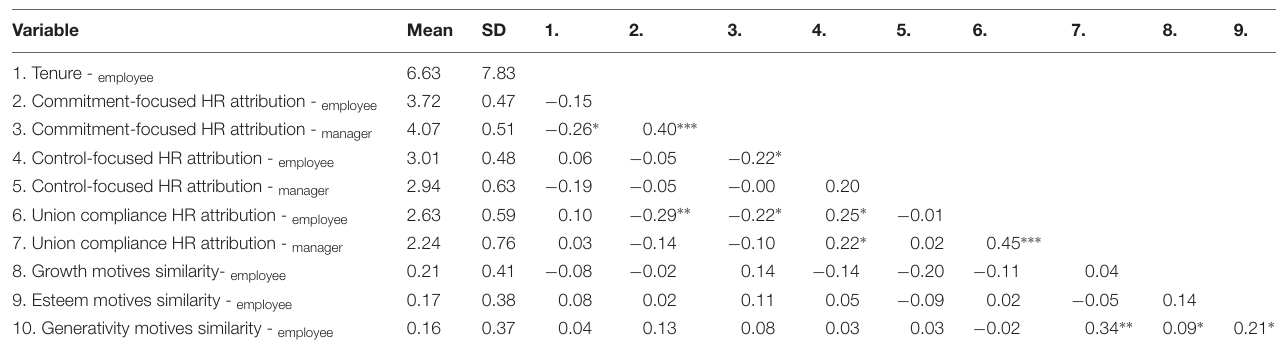
TABLE 1 | Means, standard deviations, and correlations ( N = 87 triads, 87 line managers, 174 employees).